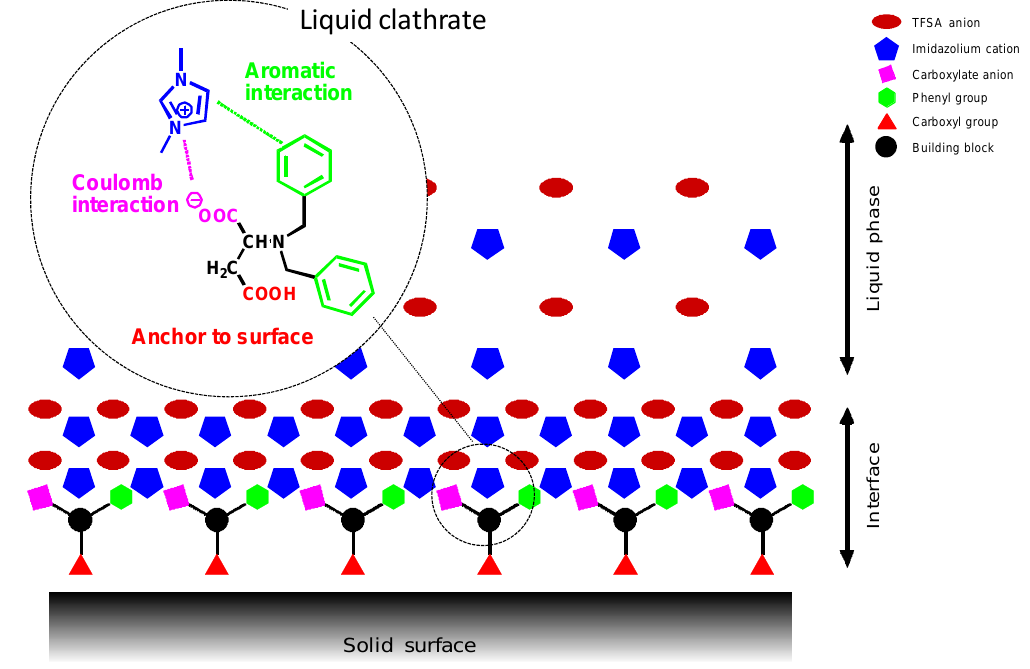
Figure 6. Proposed structure of boundary film provided by the additive and imidazolium- derived ionic liquids.